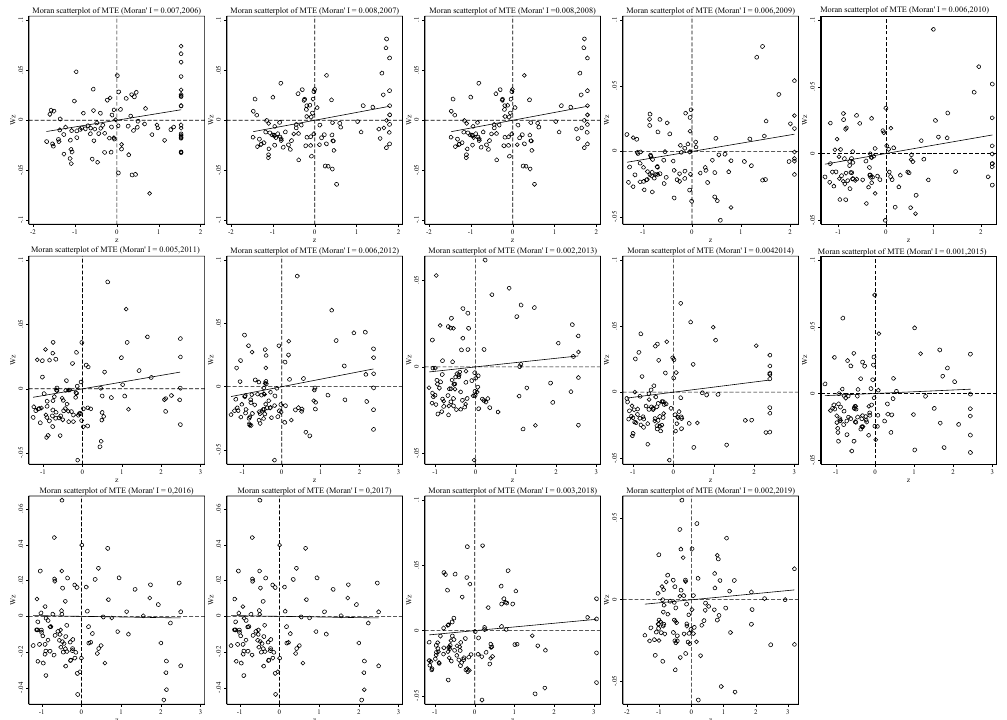
Figure 5. Distribution change of MTE Moran’s I scatter plot from 2006 to 2019.